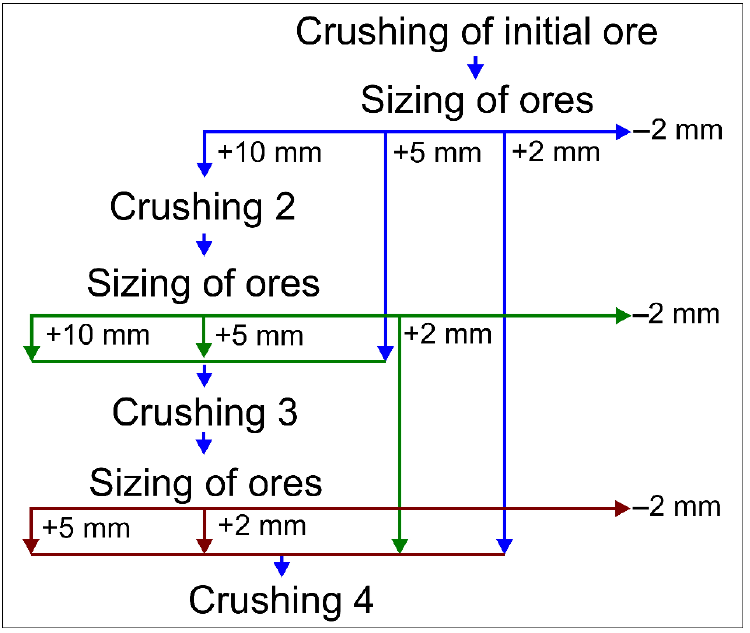
Figure 1. Disintegration scheme of iron ore samples.